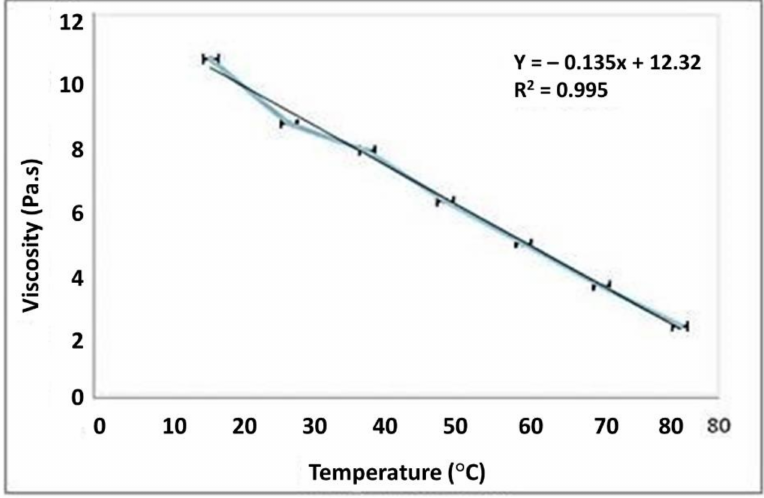
Figure 2. Graphical representation of temperature dependant viscosity (1% w / v solution of